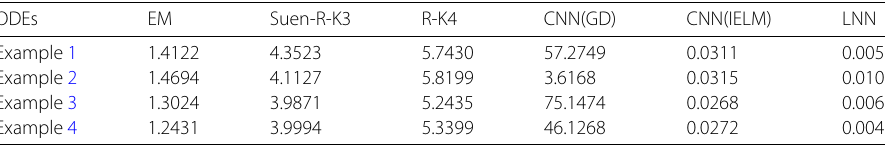
Table 4 Execution time of different methods for first-order